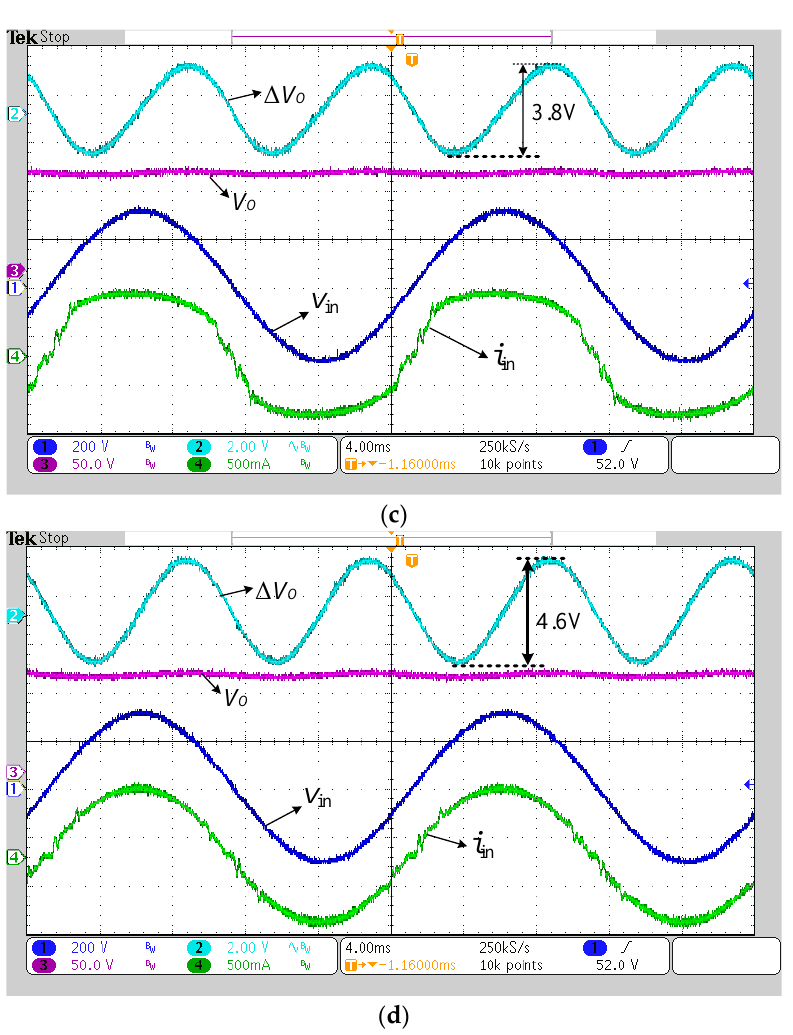
Figure 18. Experimental waveforms of Δ V O , V O , v in , and i in with rated output current, 110 Vac and 220 Vac input voltage. ( a ) COT with 110 Vac; ( b ) VOT with 110 Vac; ( c ) COT with 220 Vac; ( d ) VOT with 220 Vac.